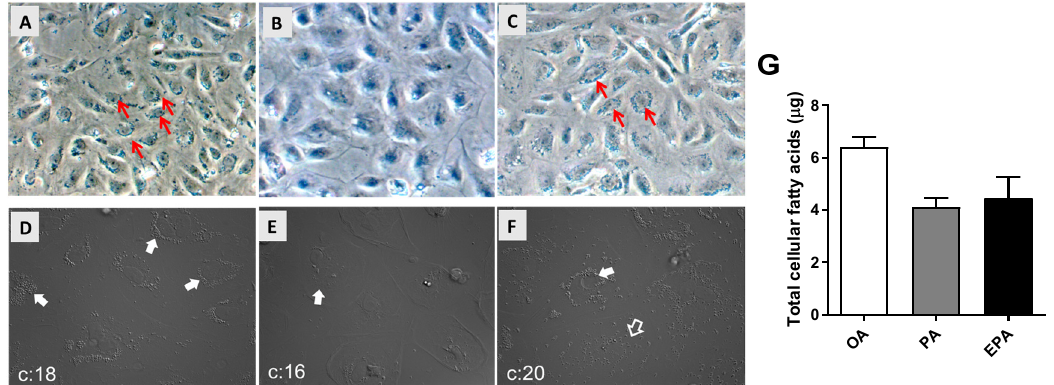
Figure 1. Microscopic observation of lipid droplets ( A – F ) and total fatty acid content quantified by gas chromatography ( G ) in mature Atlantic salmon adipocytes. Di ff erentiated cells at day 9 were incubated with oleic, palmitic, or eicosapentaenoic acid for 72 h. Images were taken with a 20 × magnification. All arrows, regardless of color, point to areas with a high presence of lipid droplets. Data are shown as mean + SEM ( n = 3) and analyzed by one-way ANOVA ( p = 0.0548). OA = oleic acid, PA = palmitic acid, and EPA = eicosapentaenoic acid. Table 1. Fatty acid composition (% of total) in mature Atlantic salmon adipocytes. Di ff erentiated cells at day 9 were incubated with oleic (OA), palmitic (PA), or eicosapentaenoic acid (EPA) for 72 h (mean ± SEM; n =